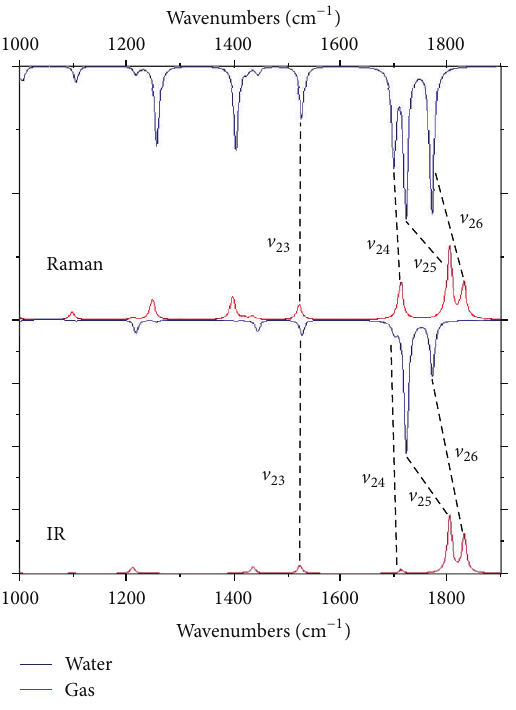
Figure 6: IR and Raman spectra of uracil in gas and water solution in the 1000–1900 cm −1 wavenumbers range. Lorentz line shapes with a full width at half maximum of 10cm −1 were used. CAM- B3LYP/aug-cc-pVDZ